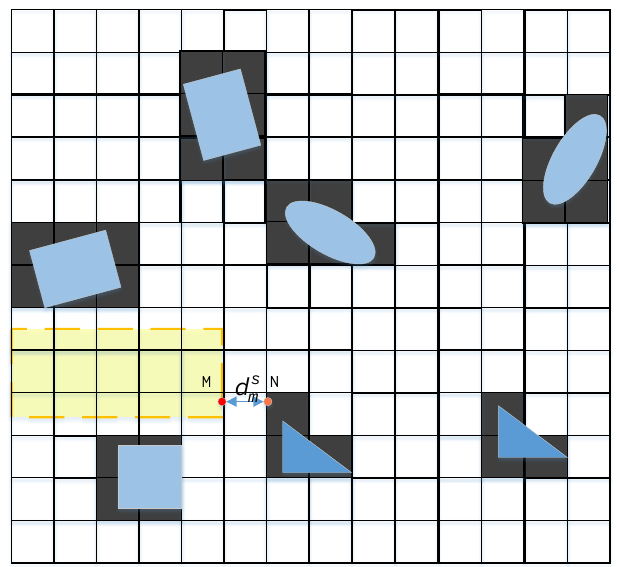
Figure 2. The boundary of the static-layer corridor